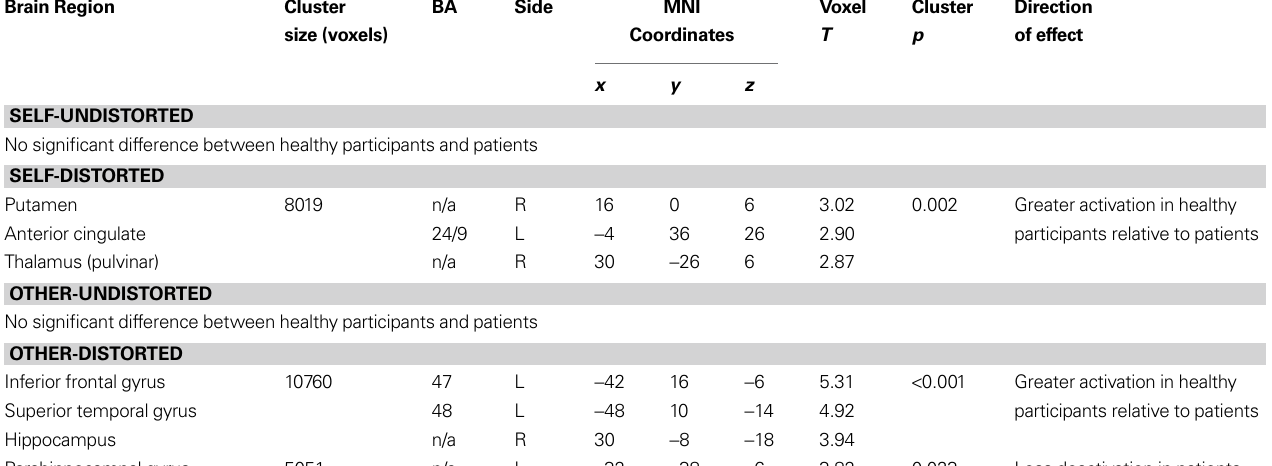
Table 5 | Brain areas differentiating the healthy and CBTp + TAU groups (voxel threshold p = 0.05, cluster p corrected for multiple comparisons). Brain